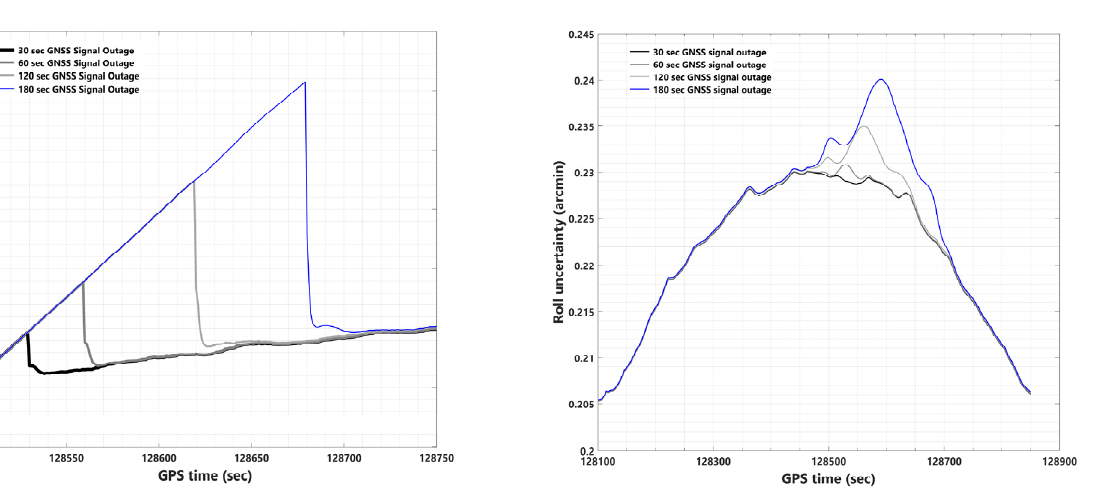
Figure 6. Uncertainties of the roll using forward KF processing and assuming different GNSS signal outages.